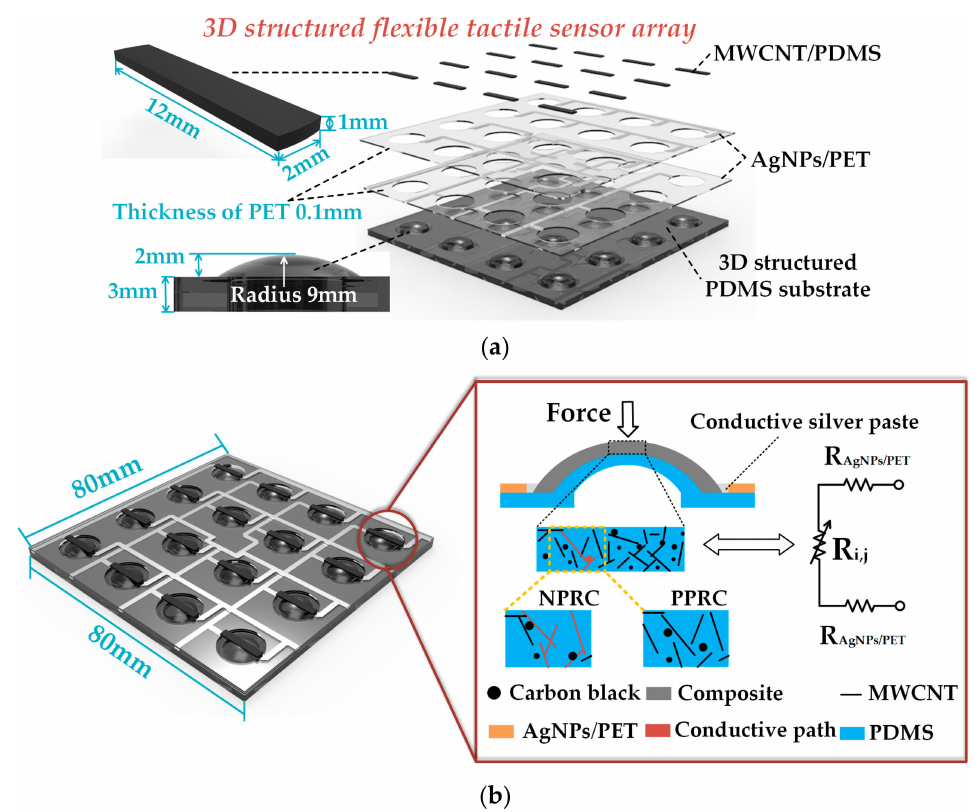
Figure 2. A schematic view of the flexible tactile sensor array: ( a ) The design of 3D structural flexible tactile sensor array; ( b ) The working principle of the 3D structural flexible tactile sensor